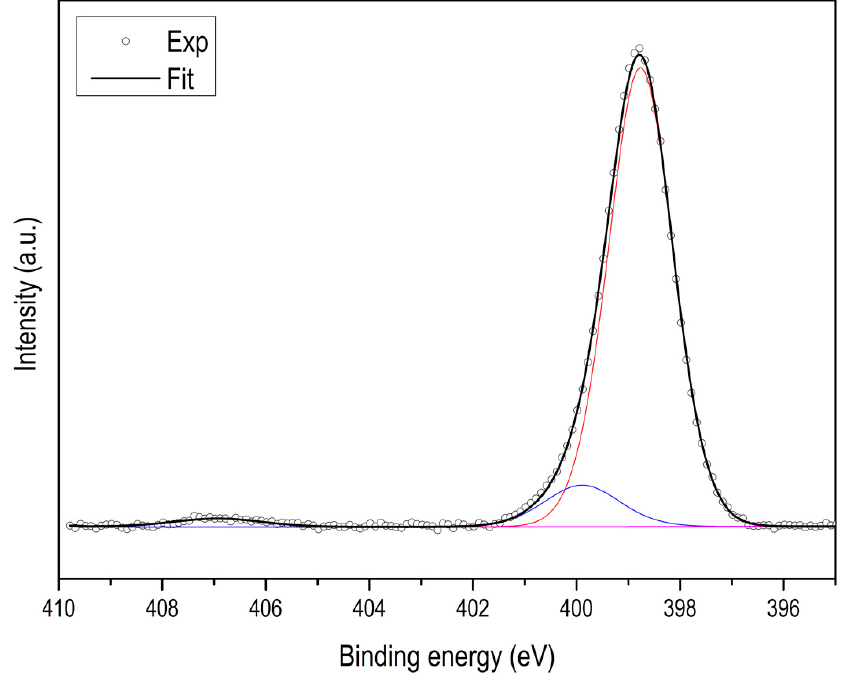
Figure A4. N XPS spectra of ZIF-67.